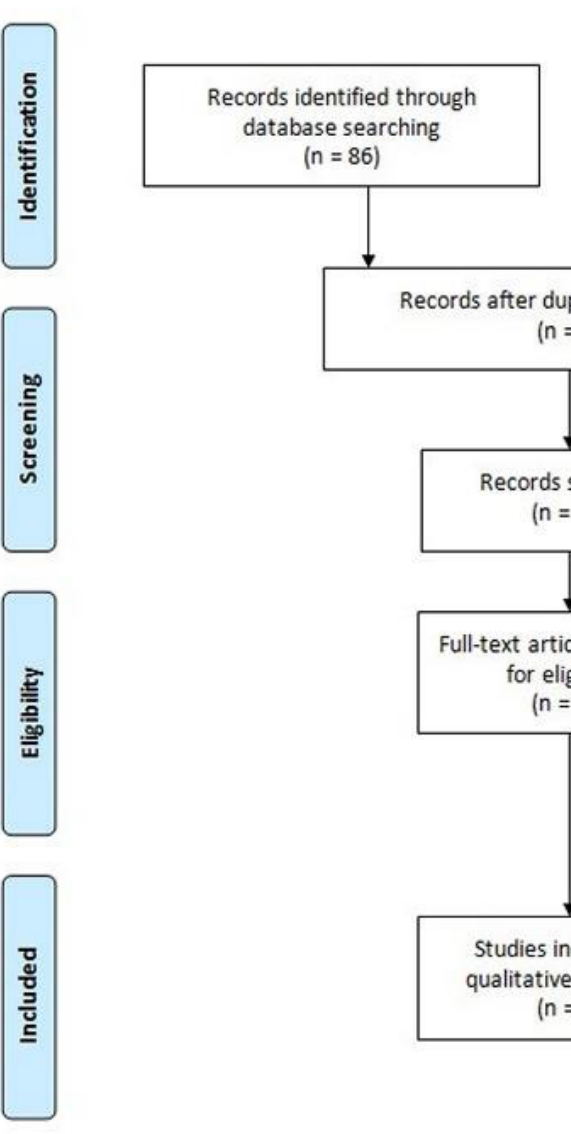
Figure 1: Flowchart of the systematic